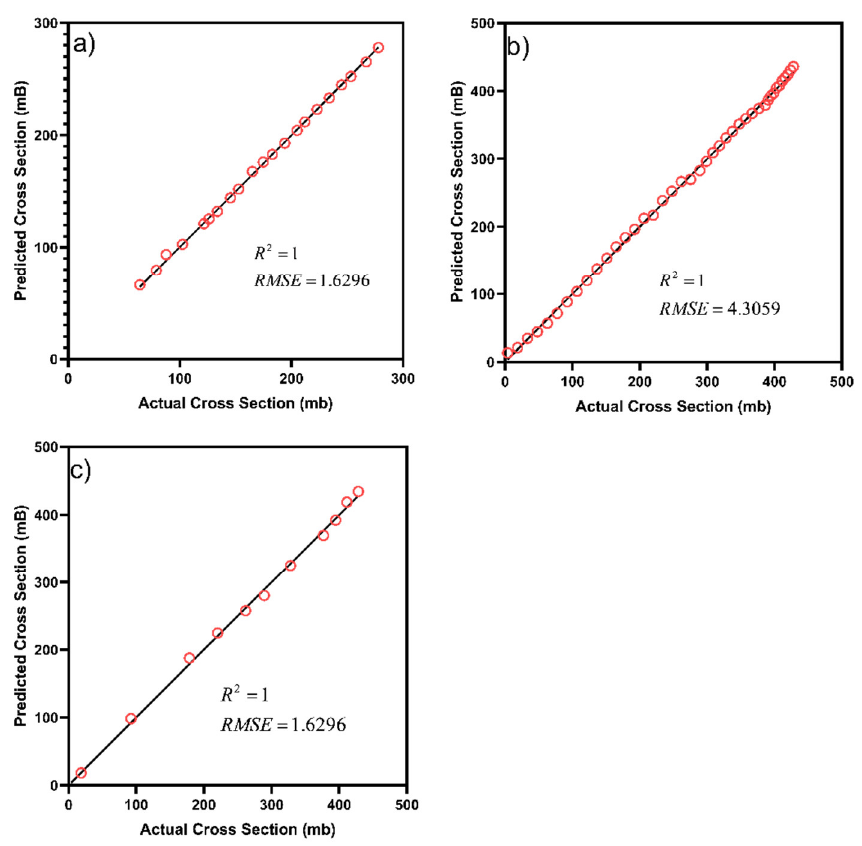
Figure 4. Graph of prediction vs. measured nuclear cross-section of 92 Mo ( n ,2 N ) 91 Mo for SVM machine learning algorithm. The black line is the ENDF/B-VIII.0 library data while the red dot is the predictions done by the SVM algorithms with ( a ) EXP, ( b ) CEP and ( c ) EXP + CEP as input.